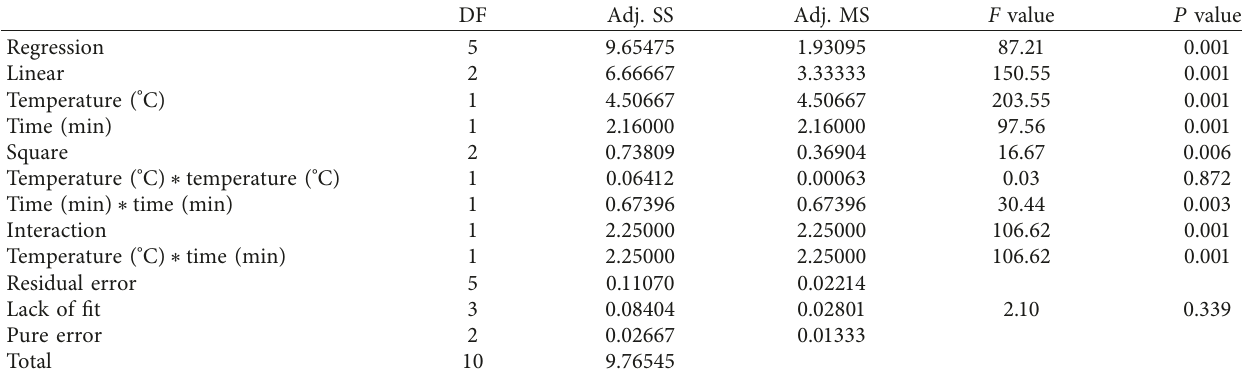
Figure 6: Contour plot for the yield (%, Y 1 ) of the turmeric leaf extract at a constant value comparing extraction temperature ( time (min, X 2 ). Table 2: Analysis of variance for the response surface model of extraction yield (%).